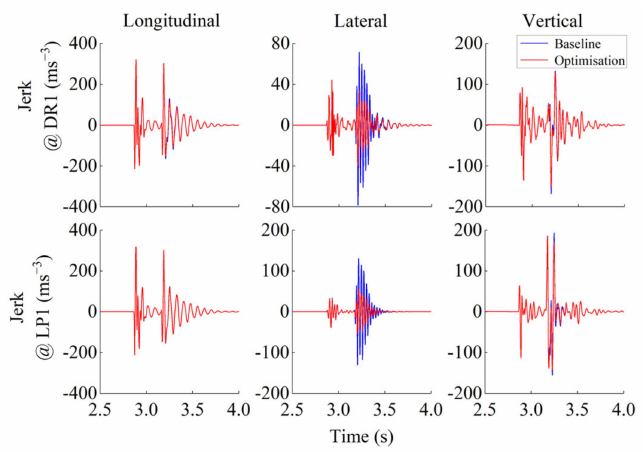
Figure 10. Comparison of running r.m.s. accelerations at seat rails between the baseline and optimized